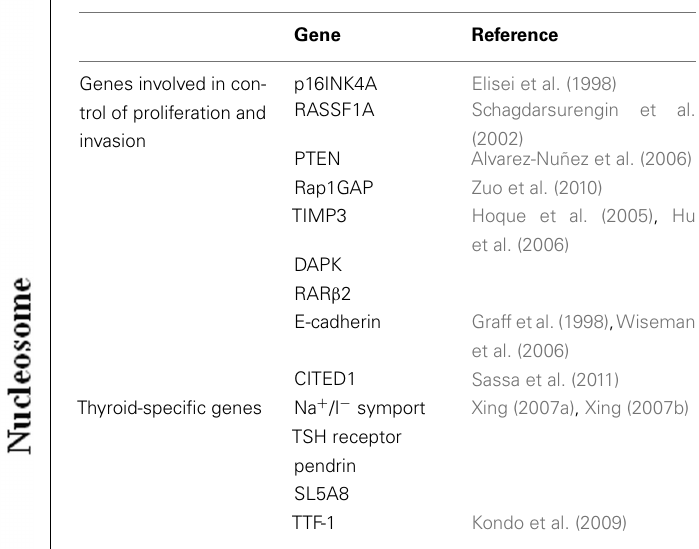
Table 1 | Epigenetic modifications in thyroid